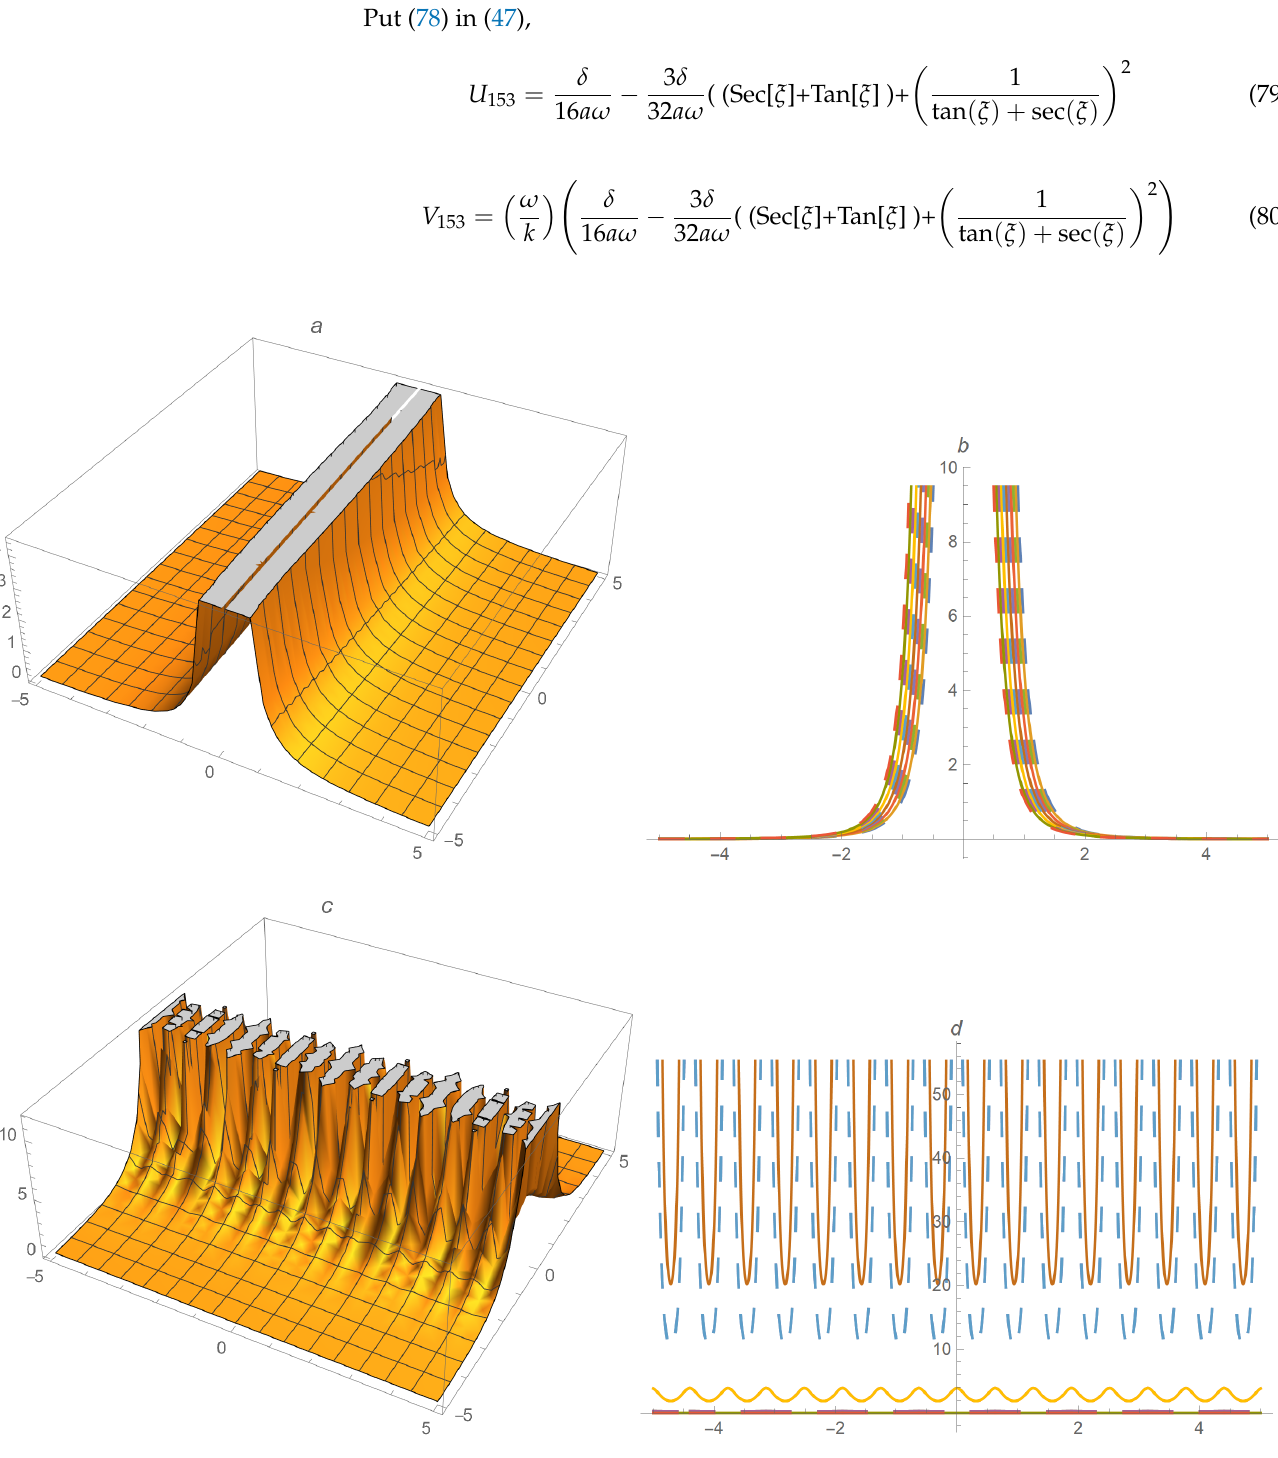
Figure 4. The profile of solutions U 143 ( a , b ) and V 143 ( c , d ) with α = 1, δ = 0.002, a = 0.1, ω = 0.5 and α = 1, δ = − 0.3, a = 0.01, ω = 0.3 respectively. C = A = − 1/2, B =